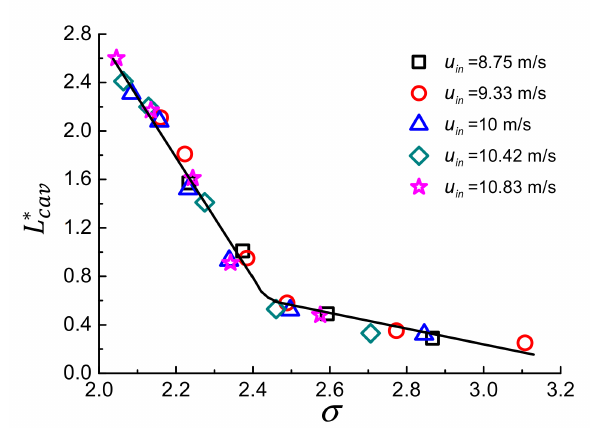
Figure 9. The nondimensional mean cavity length as a function of the cavitation number. The curve fits through the measurement